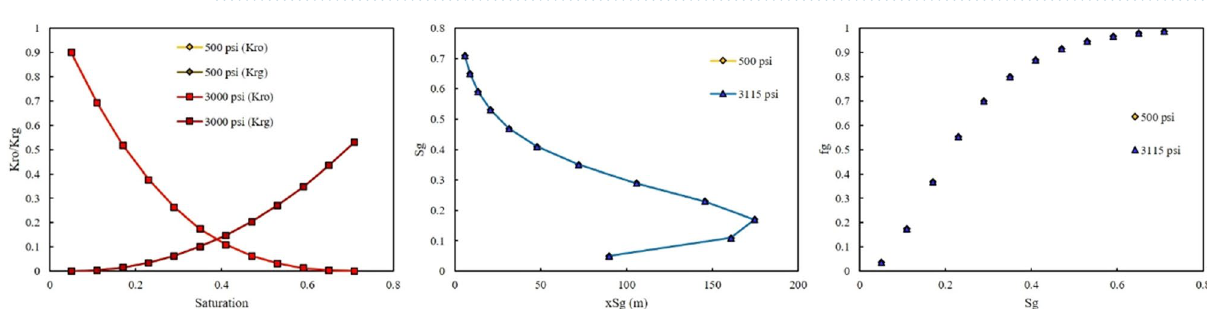
Figure 13. Effect of injection pressure of LPG on relative permeability, saturation profile, and fractional flow curve at GOR 2.5 MSCF/STB.